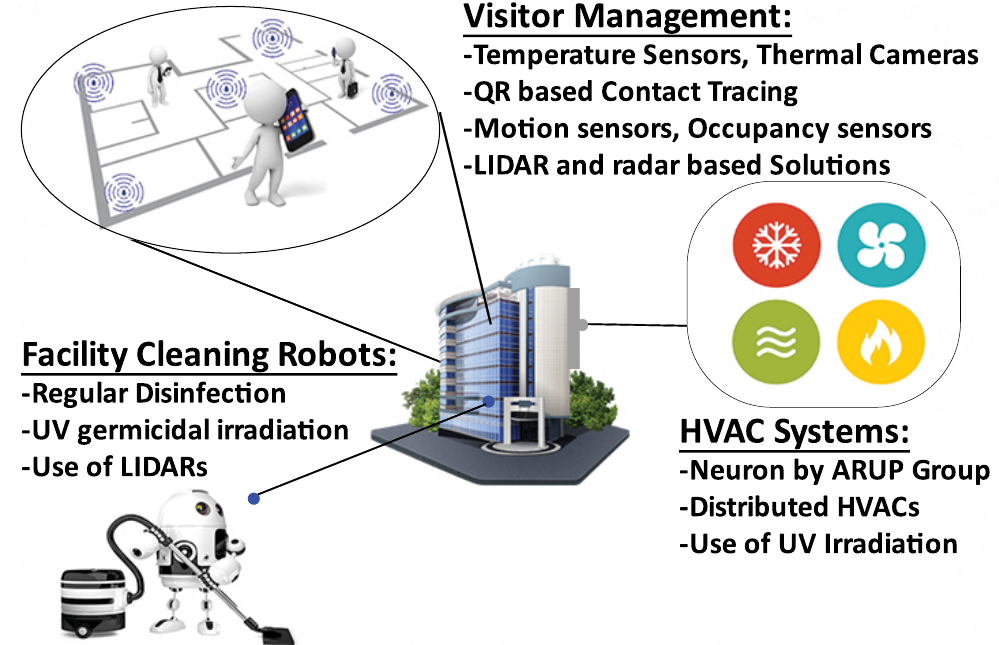
Figure 4. Recent Developments in Smart Buildings in the Wake of